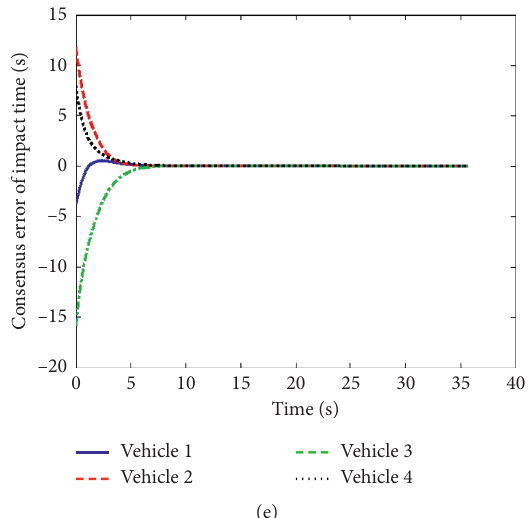
Figure 3: Simulation results under undirected and connected communication topology. (a) Vehicle trajectory. (b) Heading error. (c) Lateral acceleration. (d) Range variation. (e) Consensus error of flight time.